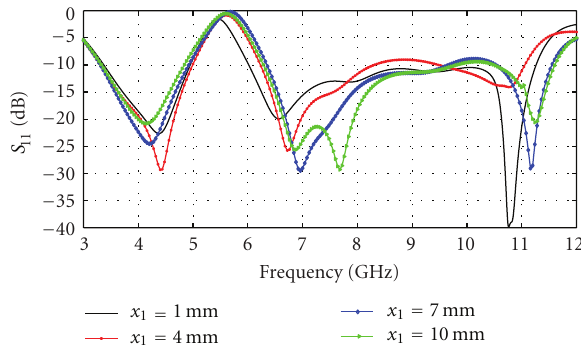
Figure 8: The time domain response of PIFA.